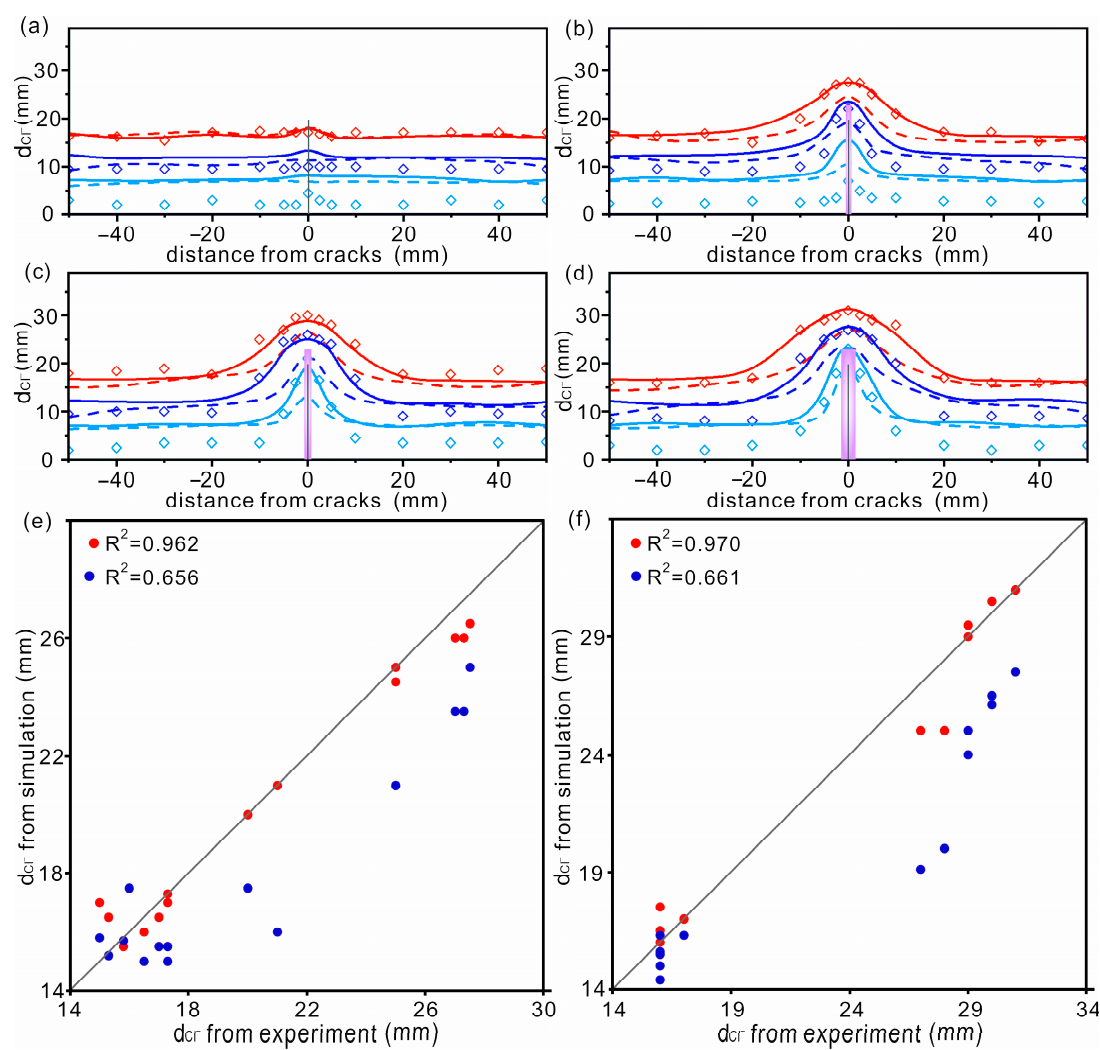
Figure 4. ( a – d ) The outermost di ff usion contours of chloride in concrete after immersion for di ff erent times. The widths of ACs are ( a ) 50 µm, ( b ) 80 µm, ( c ) 100 µm and ( d ) 200 µm, respectively. Light blue, blue and red represent data collected at 6 d, 18.5 d and 37 d, respectively. The simulation results in this work are shown as solid lines. The simulation results and experimental results taken from [14] (reproduced with permission from [14], copyright 2016 Elsevier) are shown with dashed lines and diamonds, respectively. The DZ is not considered in case with AC width of 50 µm (panel a). The purple region in panels ( b – d ) represents the DZ described by (15, 15). ( e , f ) Correlation between simulated d Cl- and measured chloride di ff usion depth at 37 d in concrete with AC widths of 80 µm ( e ) and 200 µm ( f ). The red and blue dots represent simulated data in the present work and other works [14]. The experimental results were also taken from [14].